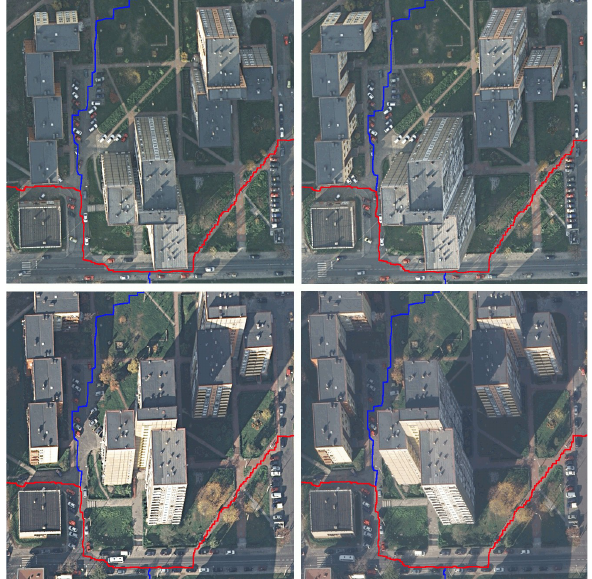
Figure 8. An example of routing the seamlines in an area with high buildings (the routes of two seamlines are shown, at the location where four orthoimages overlap, two in the top and two in the bottom